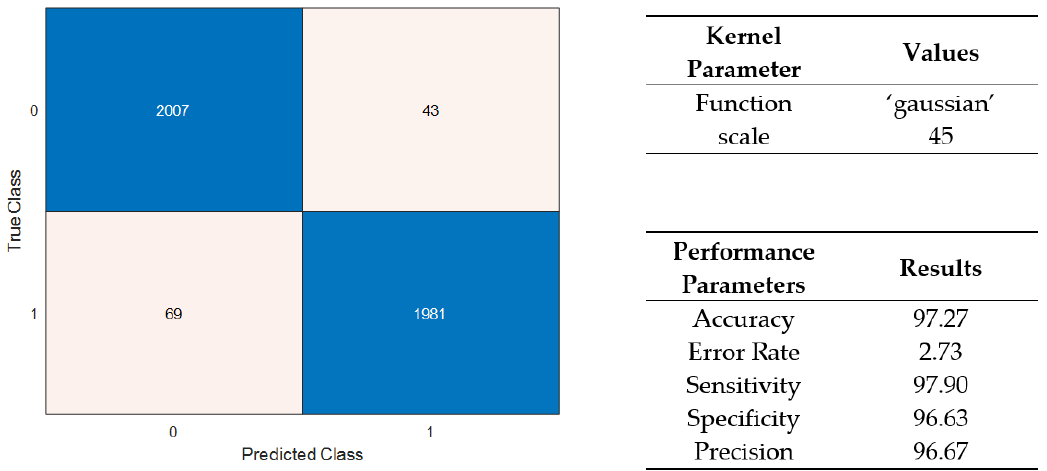
Figure 13. Confusion matrix and performance results for a Gaussian kernel with medium